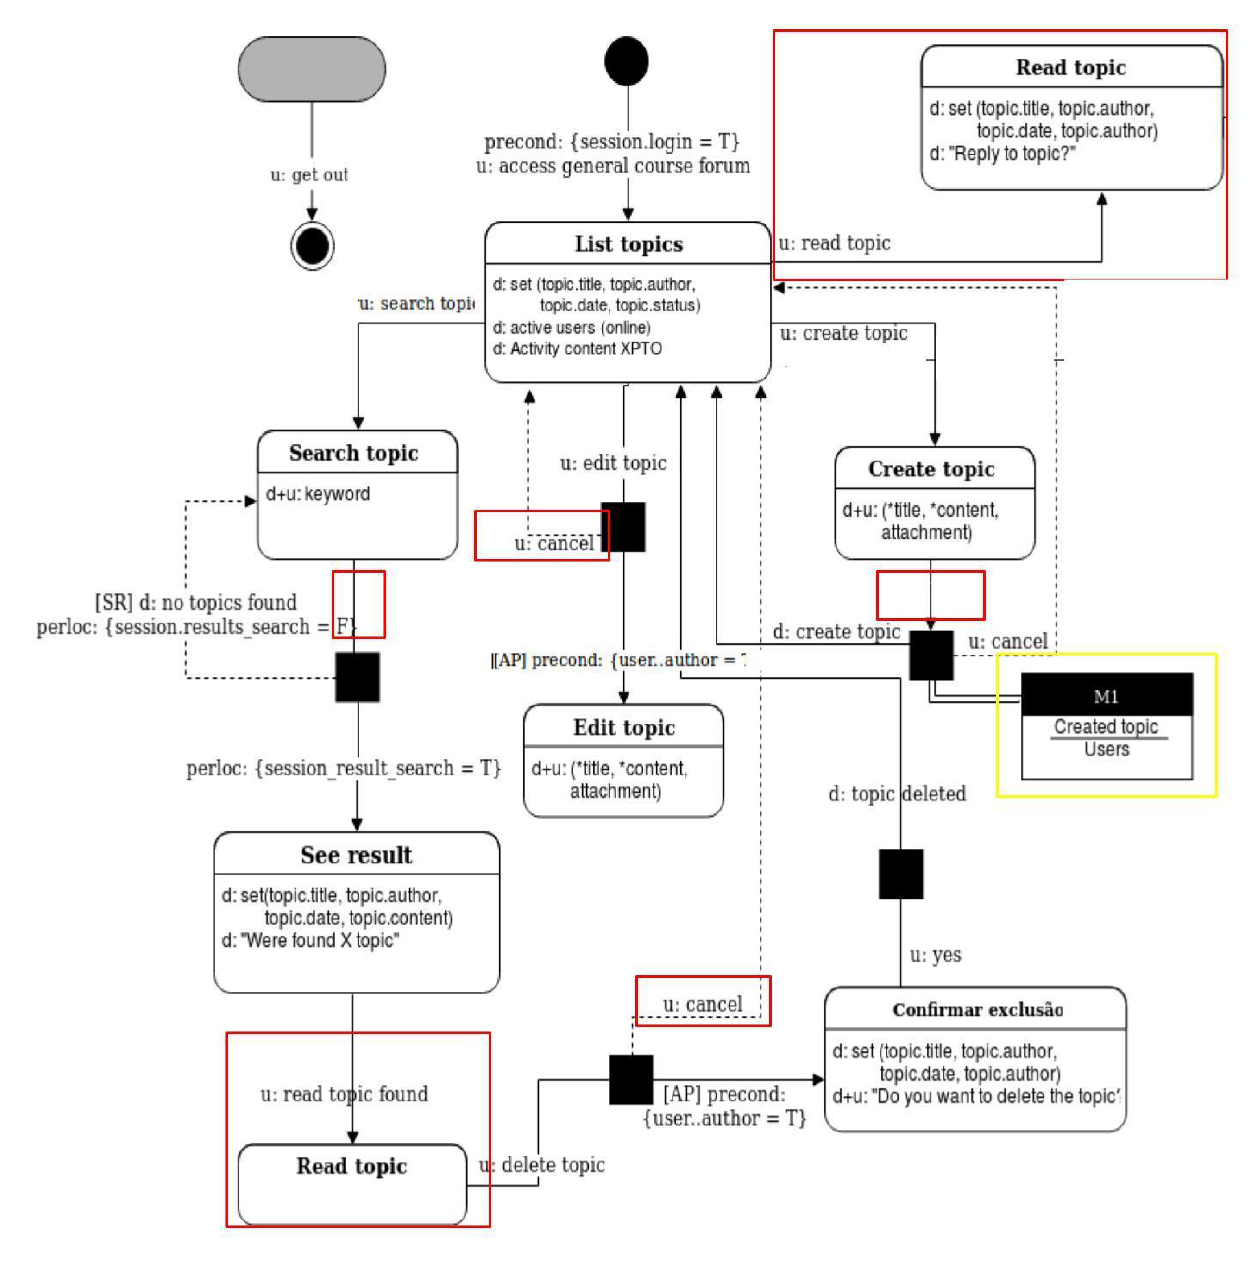
Figure 6. Diagram General